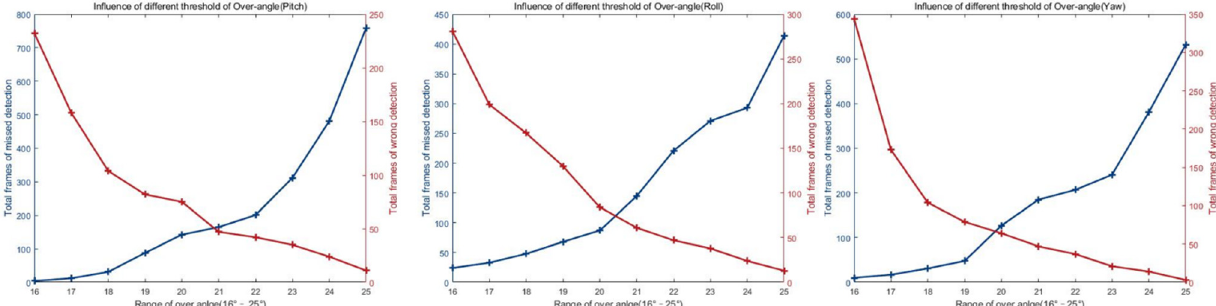
Figure 8. Missed detection and wrong detection frames of different over-angles. The left image is of the pitch over-angle. The middle image is of the yaw over-angle. The right image is of the roll over-angle.